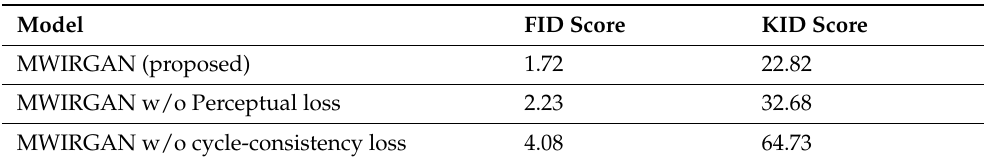
Figure 4. Ablation study results. The results show that both perceptual loss and cycle-consistency loss are essential for obtaining good-quality MWIR images. Table 2. Qualitative comparison of our ablation study. Bold numbers indicate best-performing